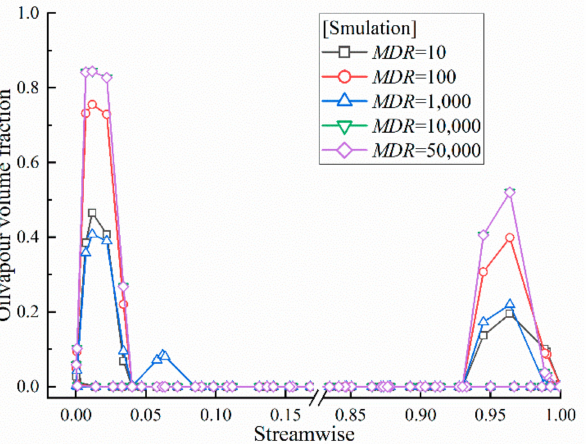
Figure 33. Oil vapor volume fraction on stator blade at stall under various maximum densities.